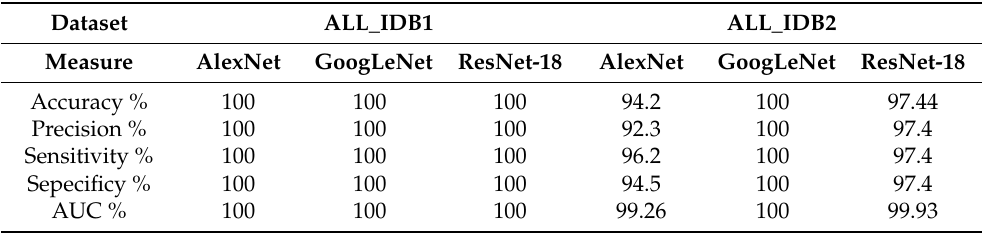
Table 5. The results of the AlexNet, GoogLeNet and ResNet-18 models on the ALL_IDB1 and ALL_IDB2